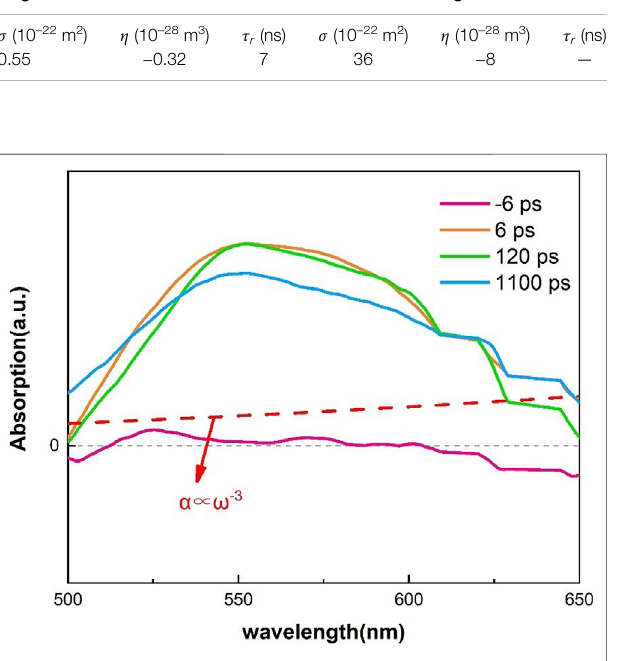
TABLE 2 | Free carrier -related nonlinear optical parameters. σ , FCA cross- section; η , FCR volume; τ r , carrier lifetime. Degenerate